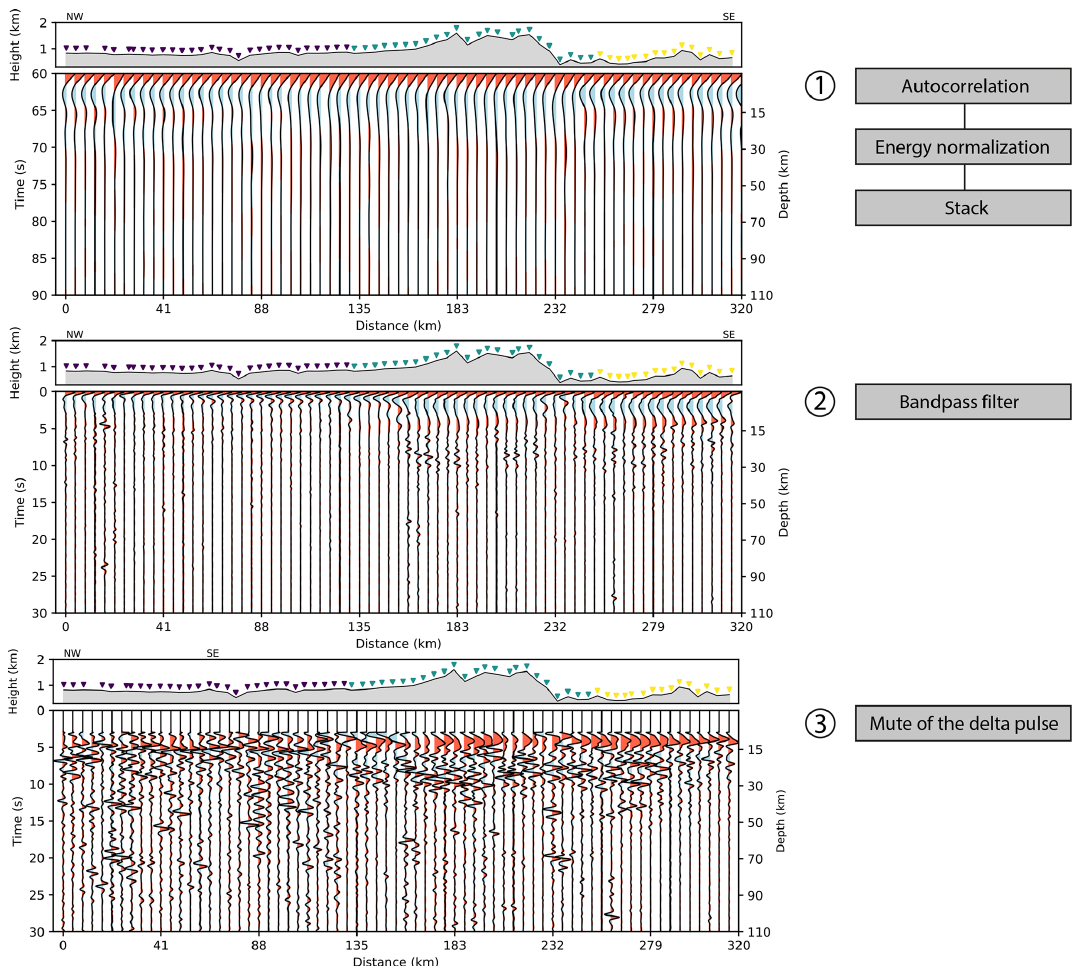
Figure 4. Stages of the processing of zero-offset reflection data to construct the lithospheric image across the Spanish Central System.